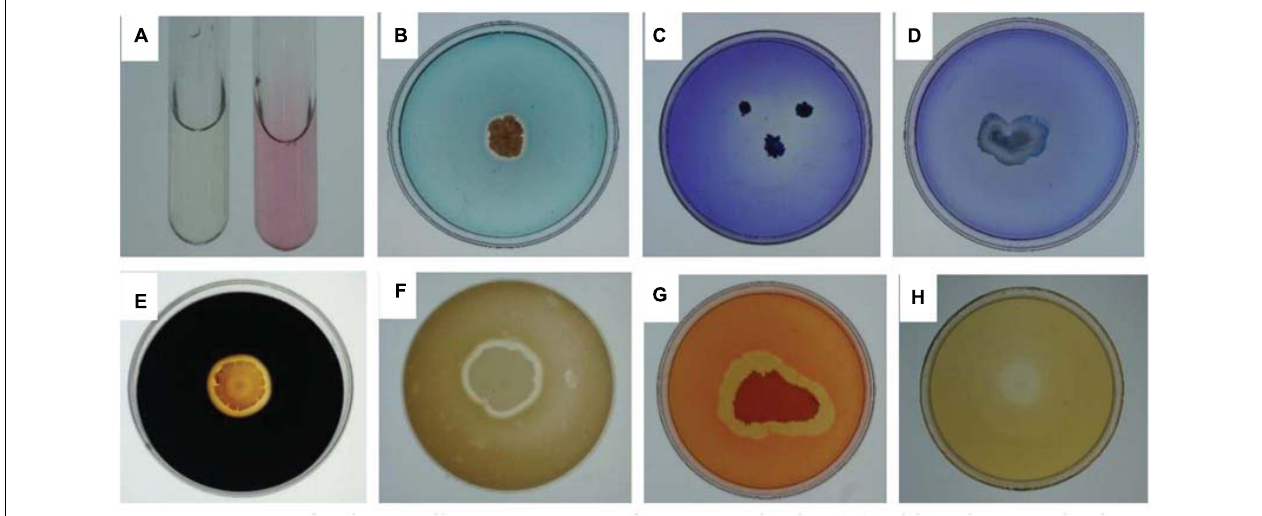
FIGURE 1 | Assays for the Bacillus cereus YN917 for IAA production (A) . Siderophore production (B) . Phosphate solubilization activity (C) . Potassium solubilization activity of YN917 (D) . Amylase production (E) . Protease production (F) . Cellulase production (G) . β -1,3-glucanase production (H) .